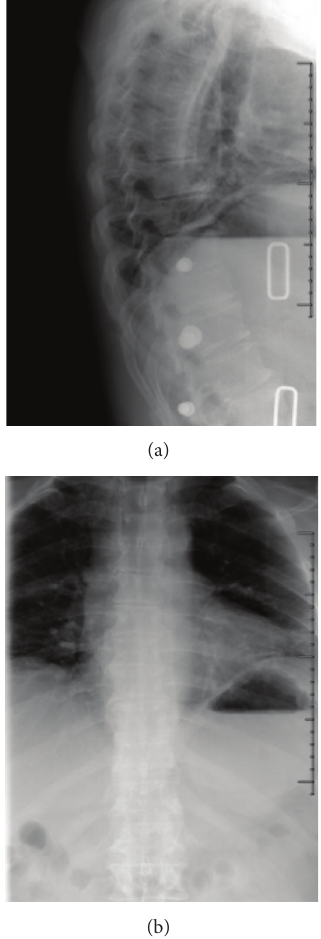
Figure 2: Sagittal (a) and anteroposterior (b) plain film in thora- columbar sacral orthosis brace at 10 weeks after the initial injury, demonstrating good osseous union and well-maintained sagittal